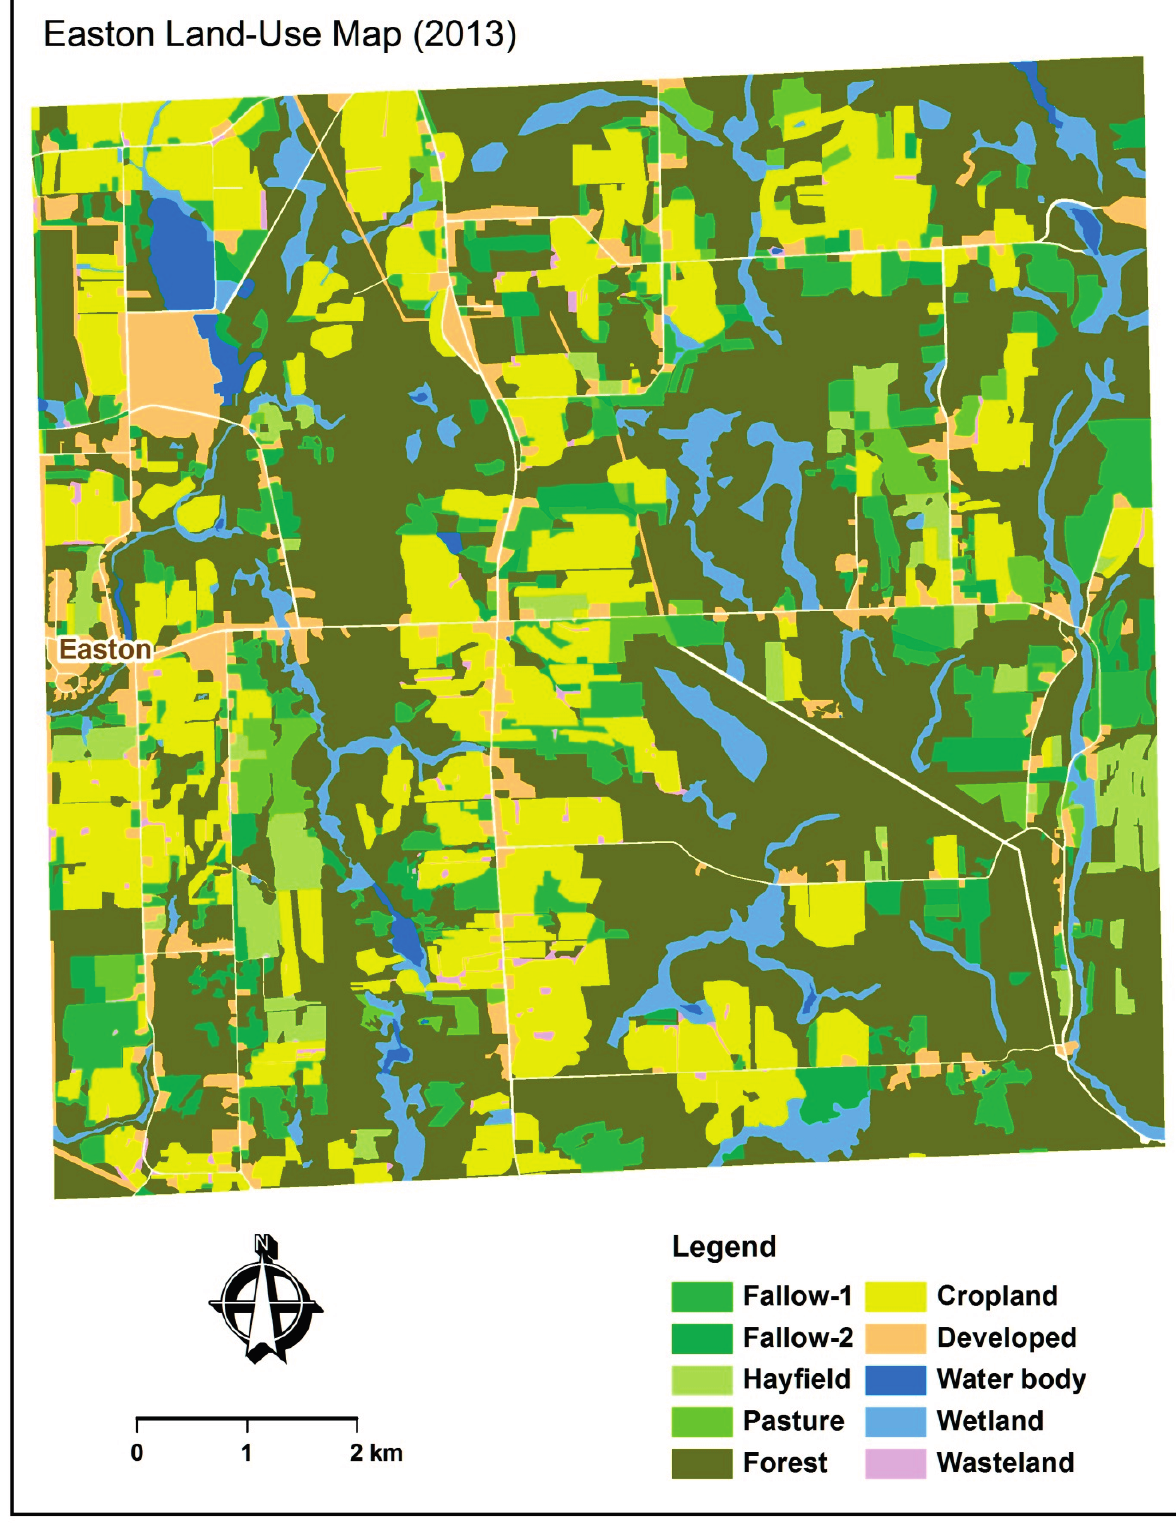
Figure A1. Land-use maps of Fort Fairfield, Presque Isle, Caribou, and Easton. Conflicts of